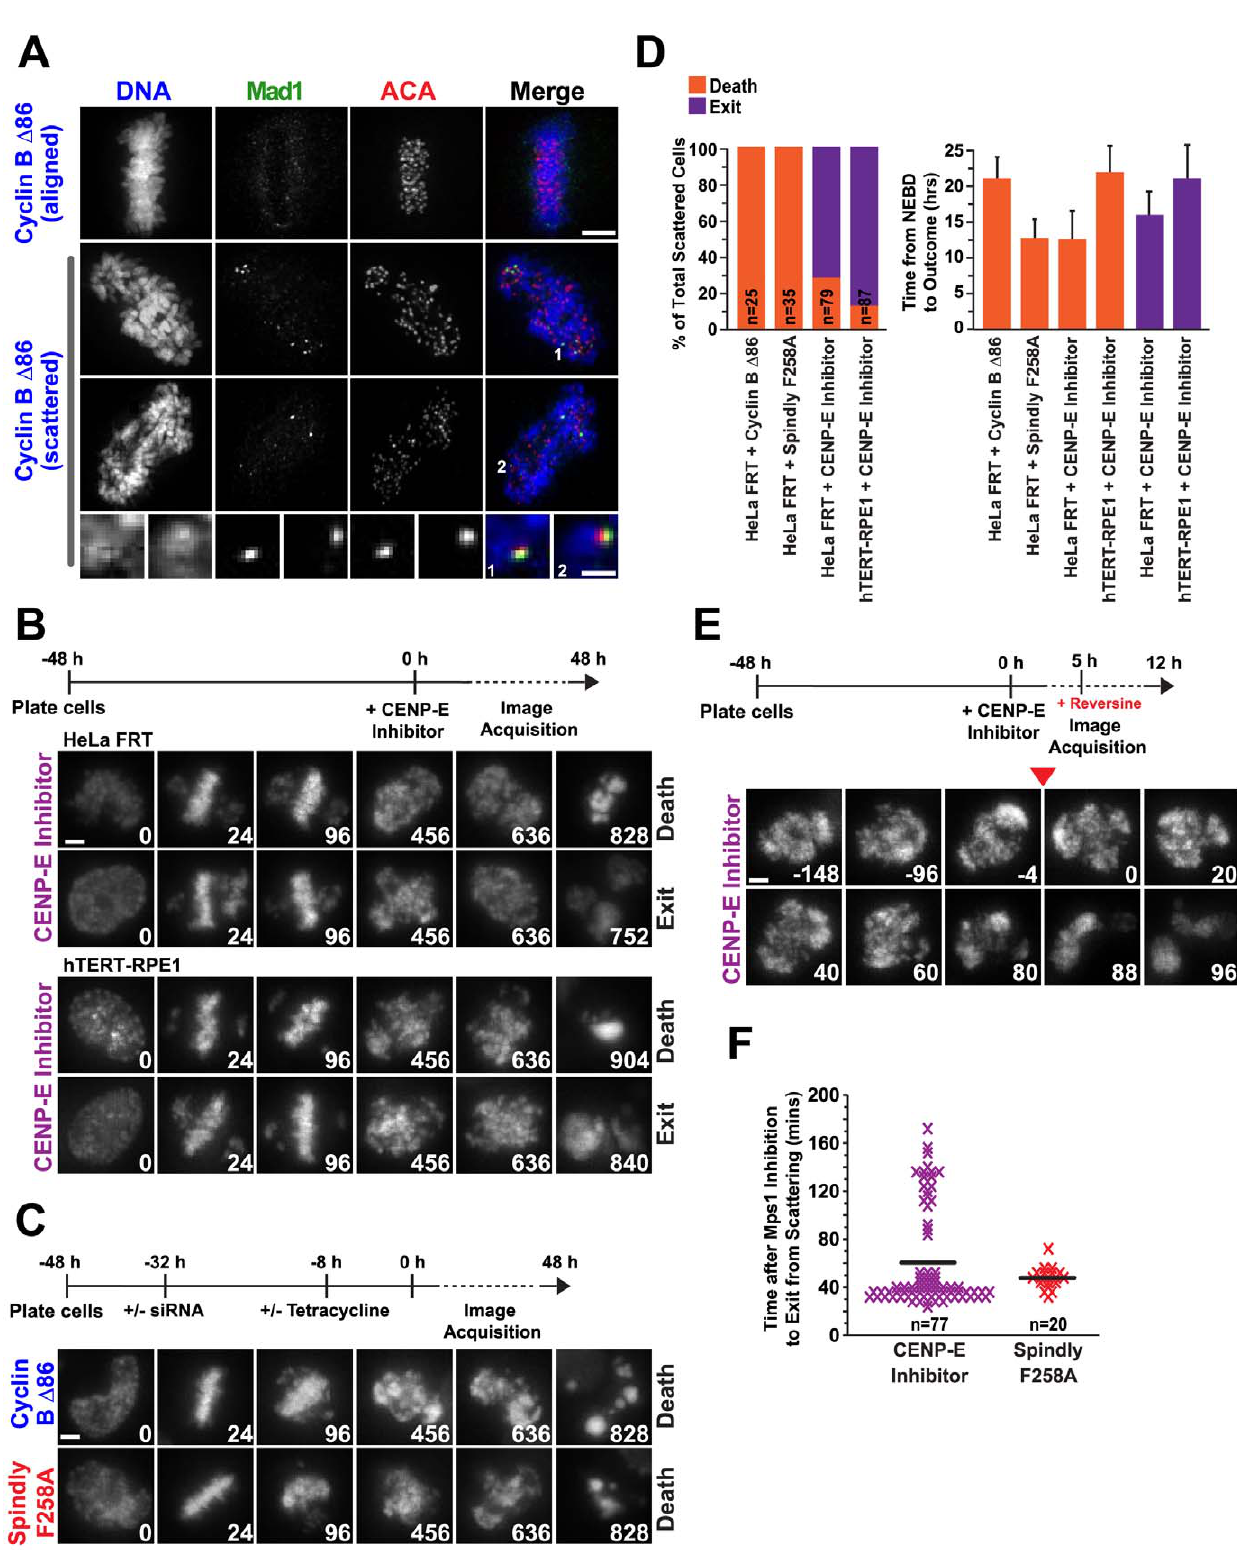
Figure 4. The spindle assembly checkpoint is reactivated upon loss of cohesion and is required to maintain the scattered state. ( A ) Immunofluorescence images of metaphase-aligned and scattered cells expressing Cyclin B D 86 stained for DNA, Mad1 and ACA. No Mad1 is seen on fully aligned chromosomes, whereas Mad1 relocalizes to kinetochores of single chromatids upon scattering. Scale bar, 5 m m; magnified image 1 m m. ( B and C ) Selected images from time-lapse imaging sequences of cells expressing histone H2b:mRFP for (B) HeLa FRT and hTERT-RPE1 cells treated with a CENP-E inhibitor and (C) HeLa FRT cells expressing either Cyclin B D 86 or the Spindly motif mutant. The scheme for each set of experiments is depicted above the images. Time (in mins) is indicated on the lower right of each panel; time 0 is NEBD. Scale bar, 5 m m. ( D ) Determination and